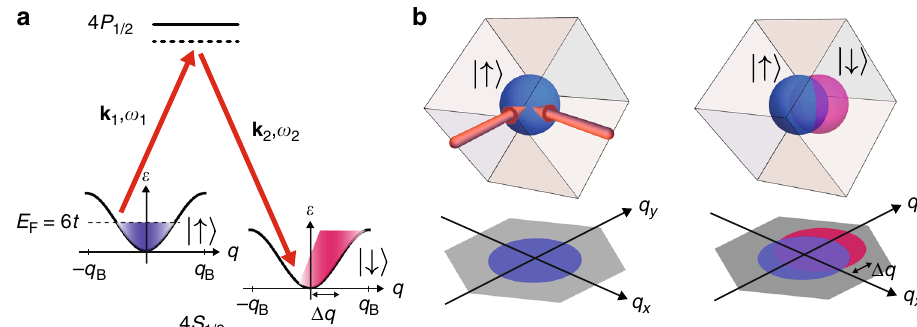
Fig. 1 Schematic diagram of method used to generate current via Raman transition. a A spin-polarized | ↑ 〉 (blue) gas is prepared in a metallic state in the ground band (with dispersion ε ) of the lattice. A pair of Raman beams (red arrows) with frequencies ω 1 , ω 2 and wavevectors k 1 , k 2 are used to quickly transfer atoms from the | ↑ 〉 to the | ↓ 〉 (red) state via the 4 S 1/2 → 4 P 1/2 electronic transition. The frequency difference δω = ω 1 − ω 2 is tuned to be resonant, and the Raman pulse equally samples all quasimomenta q in the Brilloun zone, which ranges along one direction from − q B to q B = ℏ π / d , where d ≈ 390nm is the lattice spacing. The Raman transition introduces a momentum shift Δ q for the atoms in the | ↓ 〉 state, resulting in a net current of | ↓ 〉 atoms. b The quasimomentum distribution in 3D Brilloun zone is shown before (left) and after (right) the Raman pulse. The initial quasimomentum shift has approximate magnitude of 0.5 q B and is aligned with the direction of q y and δ k , which is along the [ − 1, − 1, − 1] direction. The imaging procedure projects the ffiffiffi p (cid:5) (cid:6) ; 1 quasimomentum distributions along the 1 ; (cid:2) 2 direction, so that the Brillouin zone has a hexagonal shape in the imaging plane, which has axes q x and q